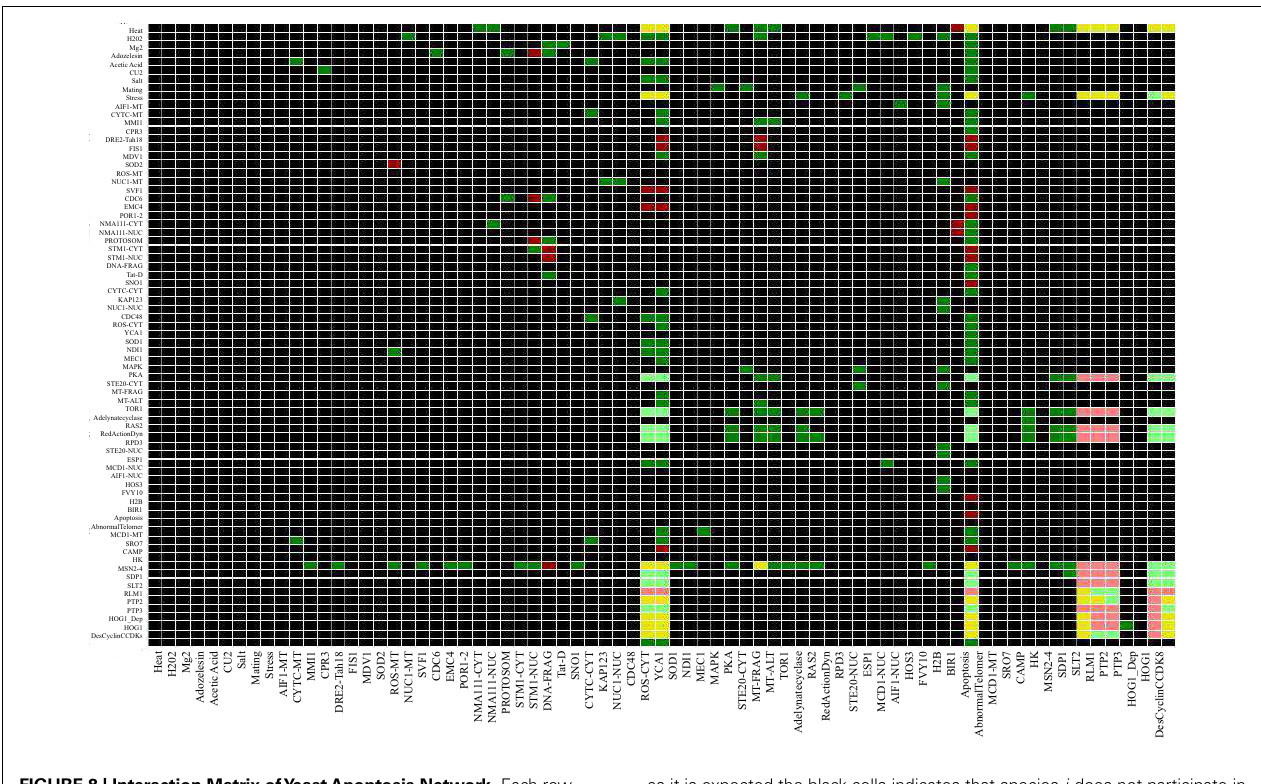
FIGURE 8 | Interaction Matrix ofYeastApoptosis Network. Each row corresponds to single species and each column corresponds to reactions. A red matrix element e ij indicates an inhibition influence of species i on reaction j . In contras a green filed shows an activation influence of species i on reaction j while a blue box indicates species i gets activated in reaction j and